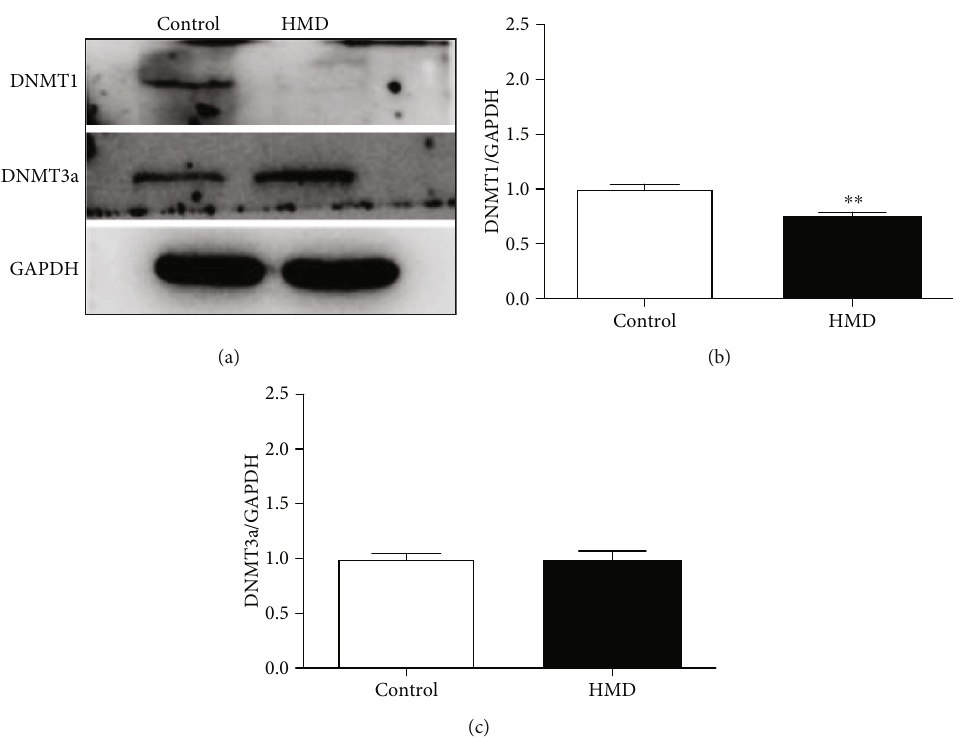
Figure 10: E ff ect of HMD on the expression of DNMT1 and DNMT3a proteins in cortex in mice. (a) Showed representative photomicrographs of DNMT1 and DNMT3a proteins expression of each group in cortex. (b) The protein expression levels of DNMT1 in cortex. (c) The protein expression levels of DNMT3a in cortex. Note: value was expressed as mean ± SEM ( n = 4 ). ∗ p < 0 : 05 vs. control group.